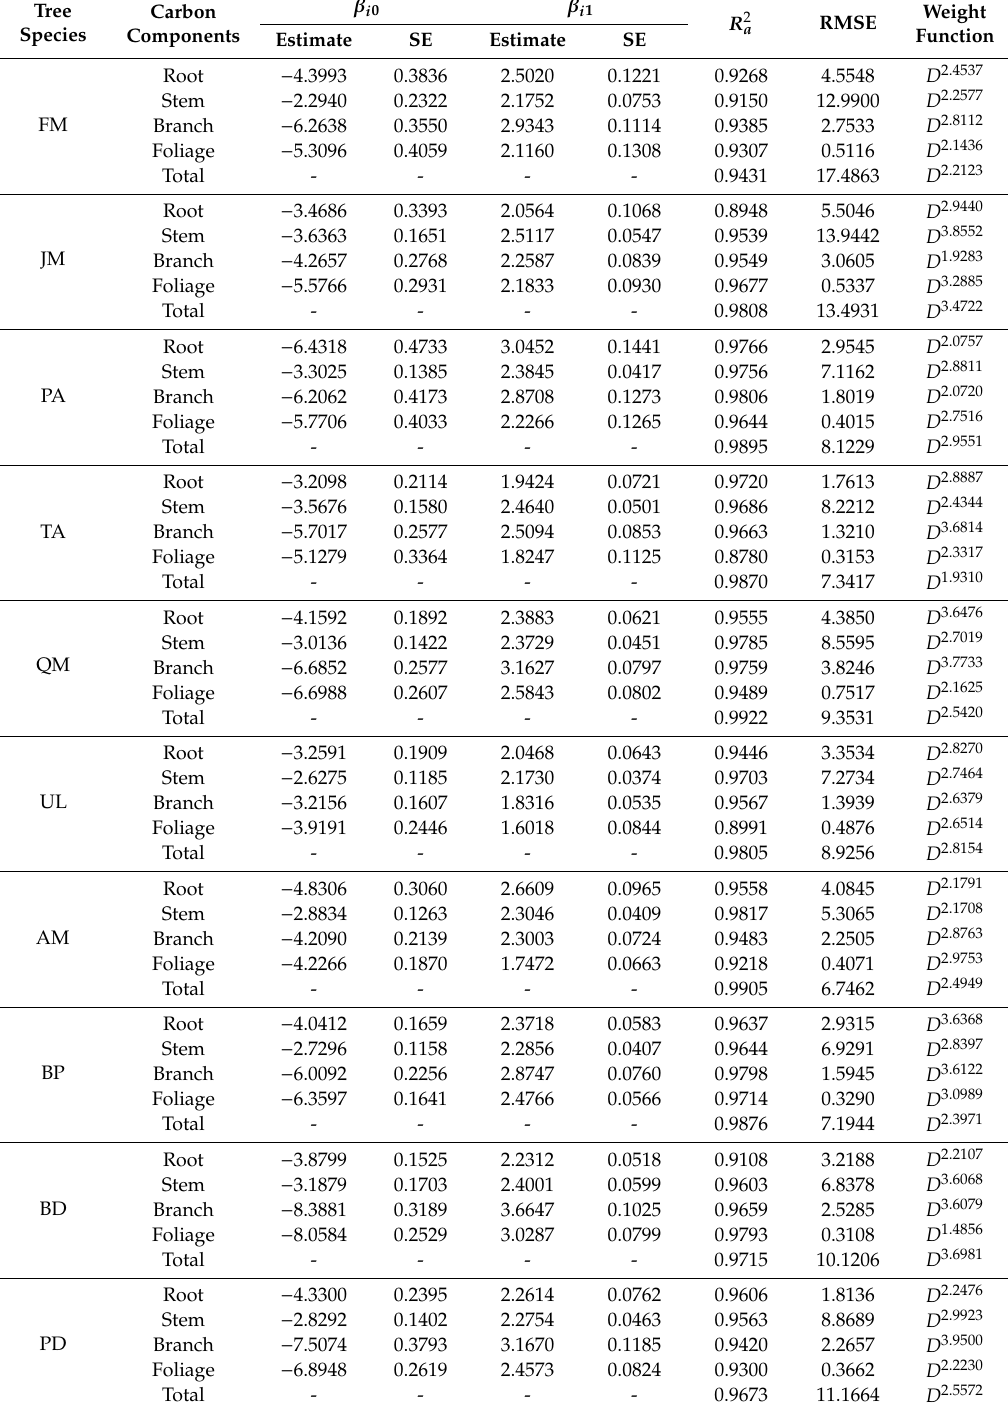
Table 3. Model coe ffi cient estimates, standard errors (SE), goodness-of-fit statistics, and weight functions for the additive system of biomass equations based on one predictor ( D only, namely